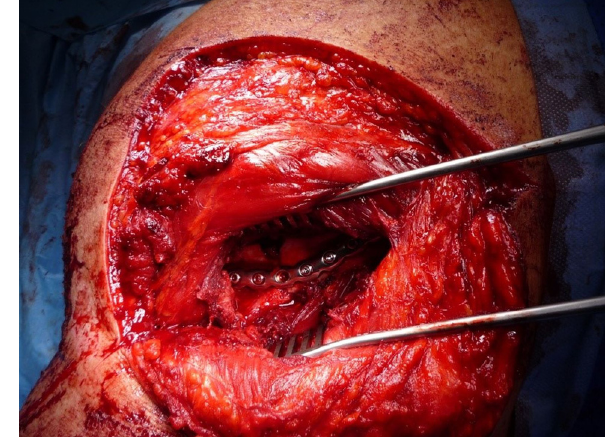
Figure 7: Osteosynthesis of the scapula using a pre - shaped